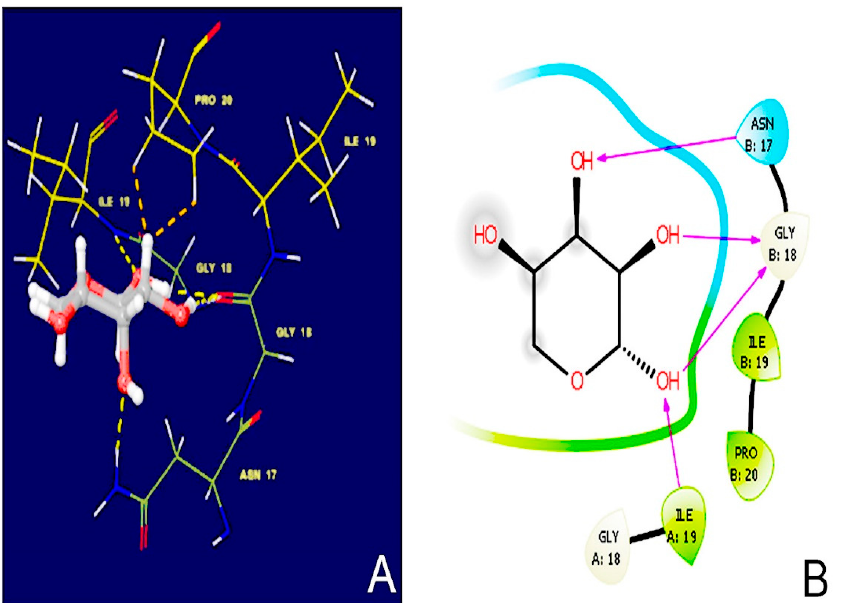
Figure 4. Results of molecular docking simulation of RB on crystal structure of collagen indicating a complex representing a